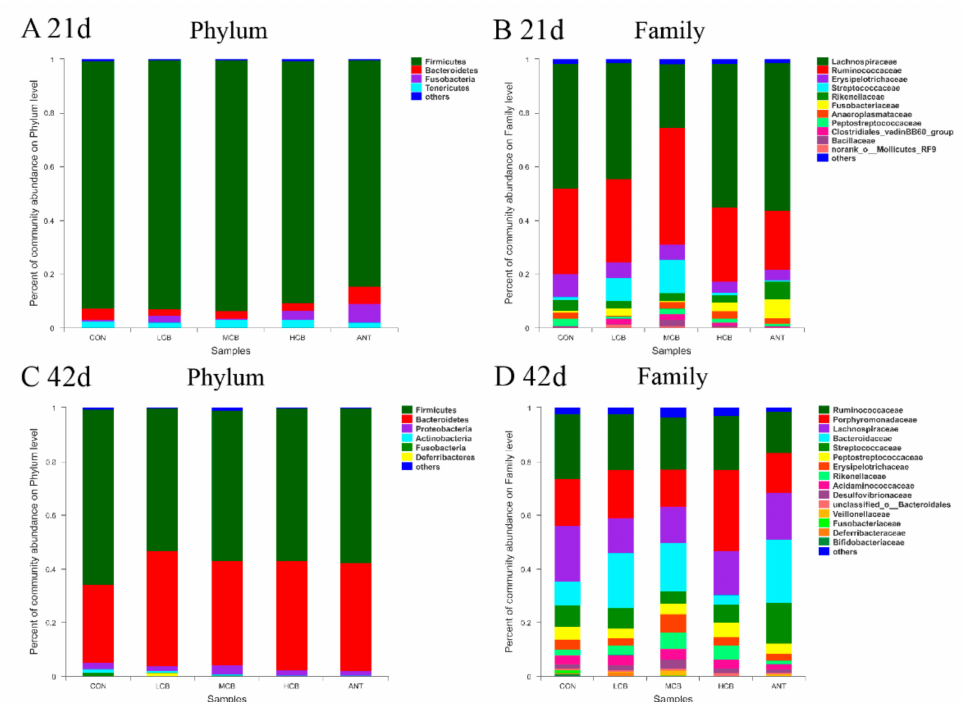
Figure 7. Relative abundance (%) and composition evaluated at the phylum and family levels of the intestinal microbiome of Pekin ducks in the five groups at different timepoint. ( A ), 21 d at phylum level; ( B ), 21 d at family level; ( C ), 42 d at phylum level; ( D ), 42 d at family level. CON, group Con; LCB, group CB200; MCB, group CB400; HCB, group CB600; ANT, group